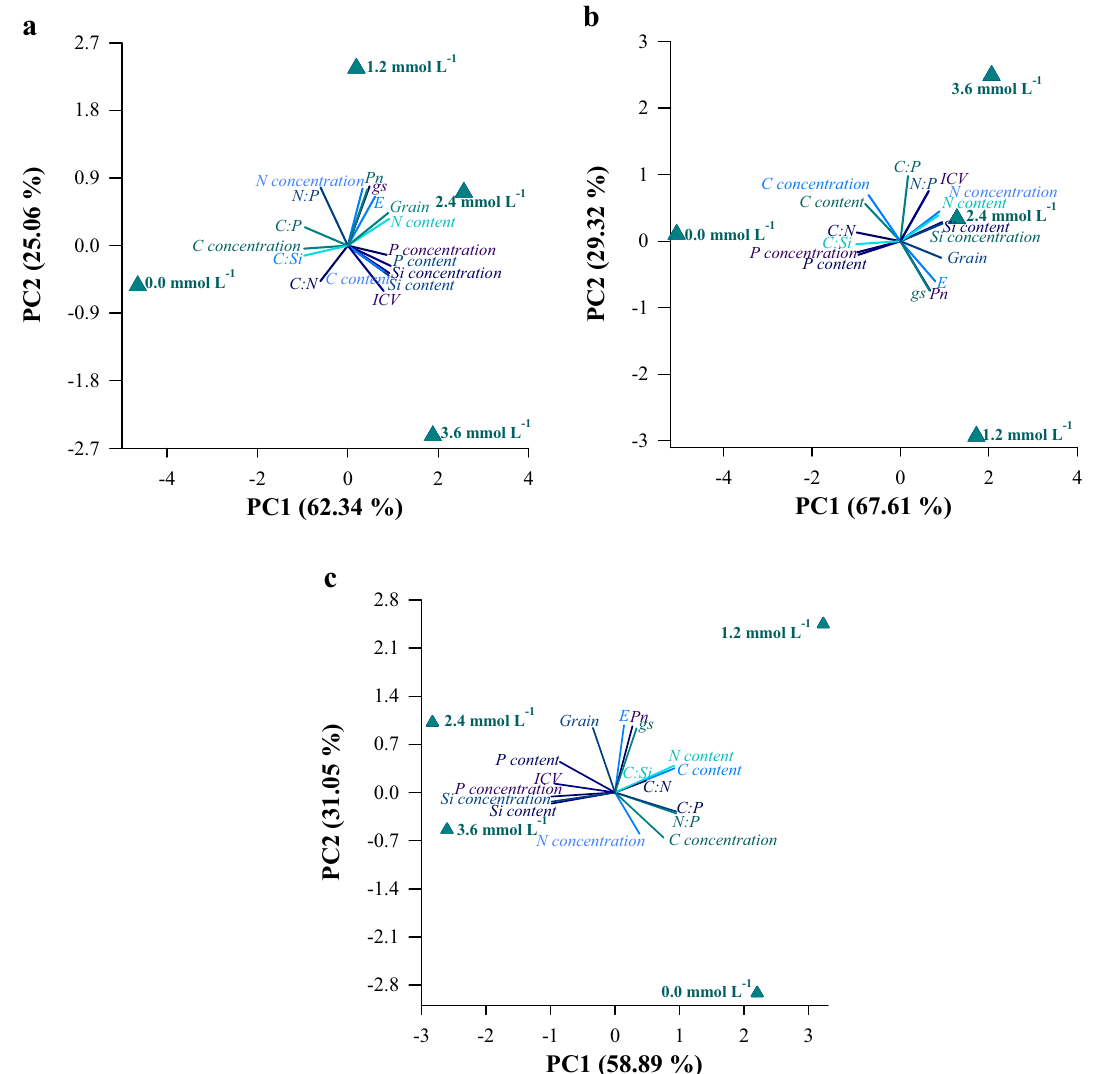
Figure 7. Principal component analysis of the C:N:P:Si concentration, accumulation, and stoichiometric ratios in the leaf ( a ), stem ( b ), and root ( c ) variables associated with physiological variables and grain yield of grain sorghum plants under different silicon (Si)